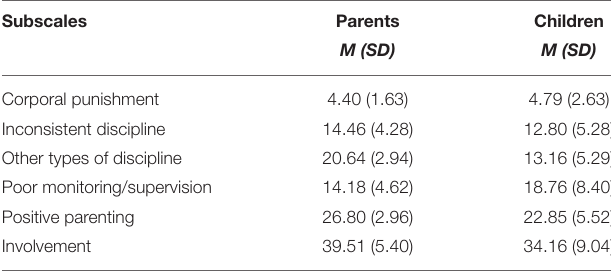
TABLE 1 | Mean scores on Alabama Parenting Questionnaire subscales at baseline for parent-child dyads ( N =